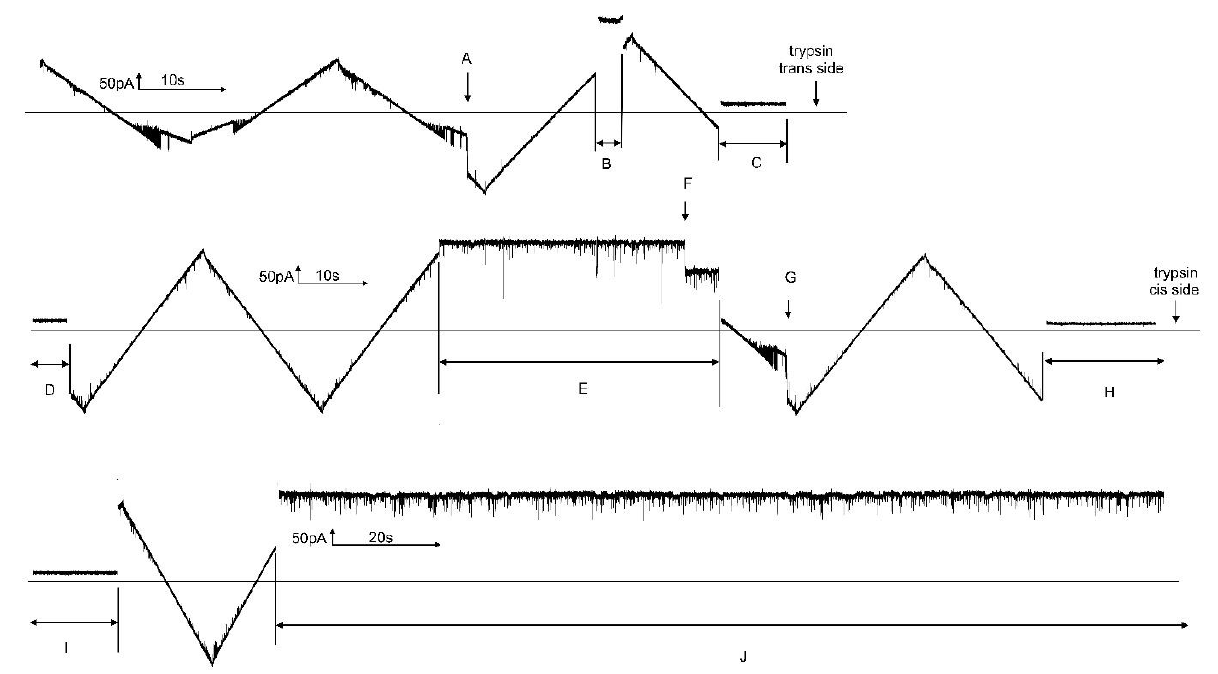
Figure 11. Trypsin cleavage of the sensor of subunit 1 from the cis side but not from the trans side. On the left side of the uppermost tracing, a single Triplin is responding to the applied triangular voltage wave (+81/ − 79 mV) with the closure of subunit 2 at elevated negative voltages. At point “A”, subunits 1 and 2 open essentially simultaneously, resulting in no gating. In region “B”, +102 mV was briefly applied followed by the resumption of the triangular voltage wave. In region “C”, + 10 mV was applied and 40 µ g trypsin was added to the trans compartment. After 10 min of exposure to trypsin, 1 mg of soybean trypsin inhibitor was added. Region “D” is after the inhibitor addition. Resuming the triangular voltage wave resulted in no gating, indicating that subunit 1 was still open. In region “E”, +92 mV was applied and subunit 1 closed at point “F”. The triangular voltage wave was resumed and subunit 2 closed followed by reopening of subunits 1 and 2 at point “G”. In region “H”, the voltage was held at +10 mV followed by the addition of 40 µ g of trypsin to the cis compartment. Trypsin was allowed to react for 10 min and region “I” is the end of that reaction time. The triangular voltage wave showed that subunit 1 was still closed. The application of +92 mV to try to close subunit 1 (region “J” and beyond) resulted in no closure of subunit